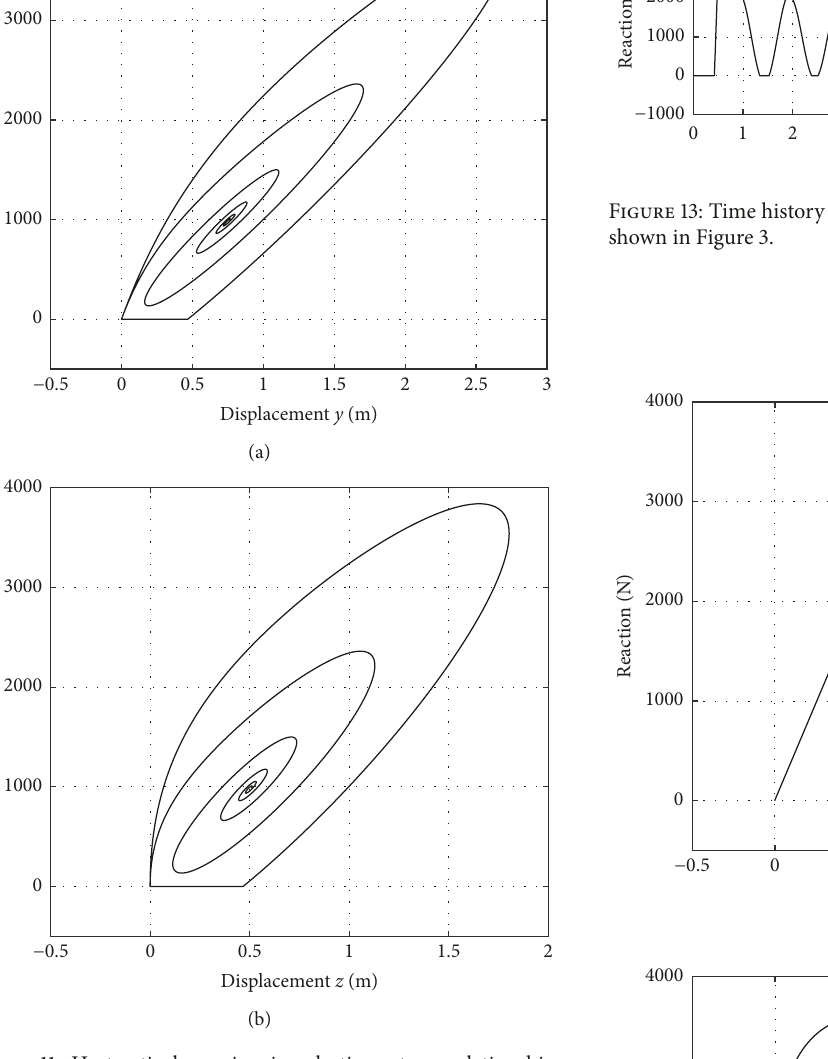
Figure 11: Hysteretic loops in viscoelastic system: relationships (𝑅,𝑦) (a) and (𝑅,𝑧) (b).